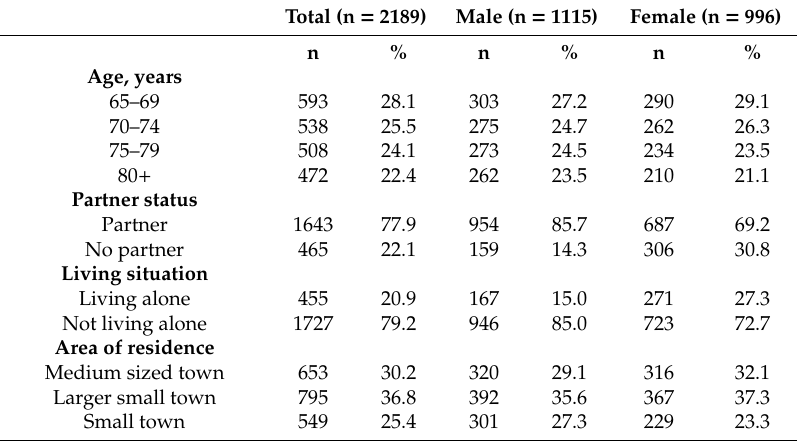
Table 1. Characteristics of the study